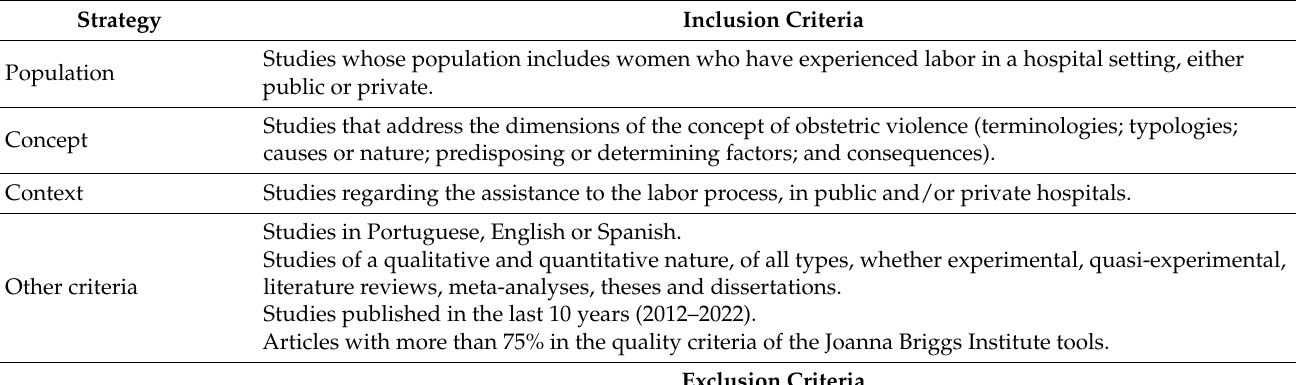
Table 1. Inclusion criteria